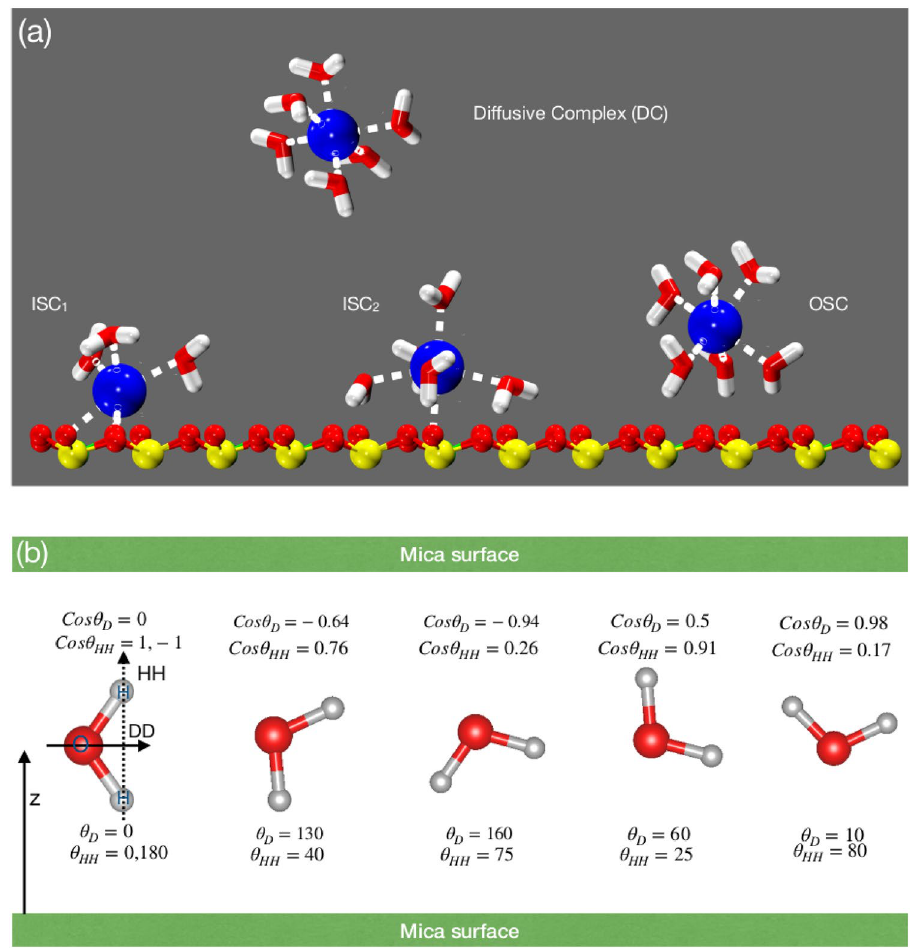
Figure 4. ( a ) Schematics illustrating the various ion hydration complexes observed. Inner sphere complex (ISC) where cation forms hydration shell with both surface oxygen and water molecules. ISC 1 is closer to the surface as compare to ISC 2 . Outer sphere complex (OSC) where cation is located one water diameter away from surface and interact with the surface via a hydration water molecule. Diffuse ion complexes which does not interact with surface neither directly nor via hydration water. ( b ) Representative configuration of water molecules observed in confined mica pore having various orientations. θ D and θ HH are the angles formed by surface normal ( e z ) with dipole and HH vectors,